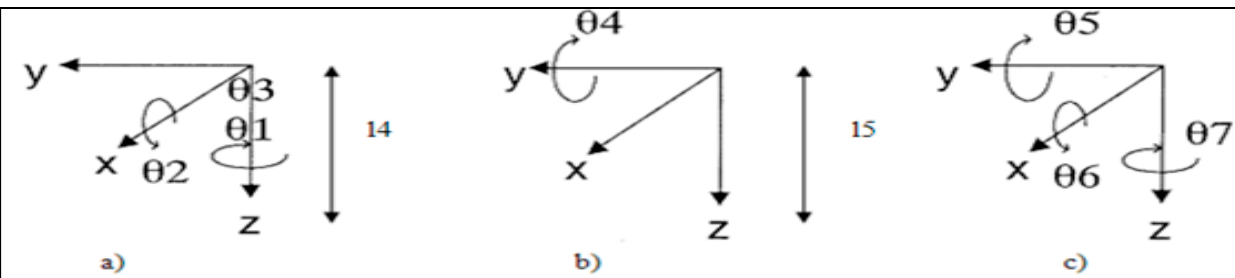
Figure 7. Angles that represent every joint, ( a ) Shoulder type, ( b ) Elbow type and ( c ) Wrist type.